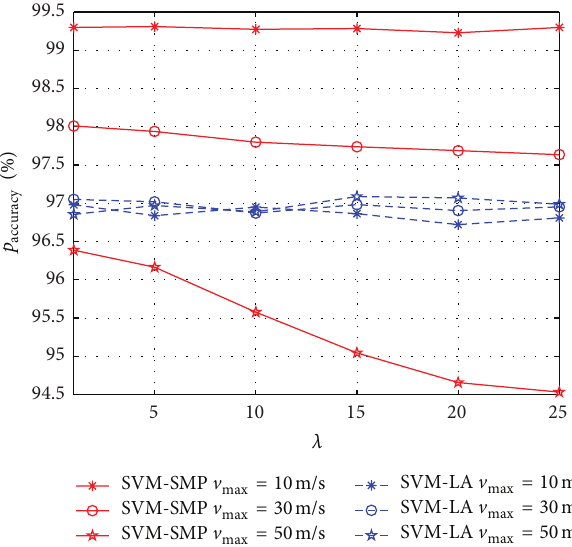
Figure 8: Prediction accuracy rate 𝑝